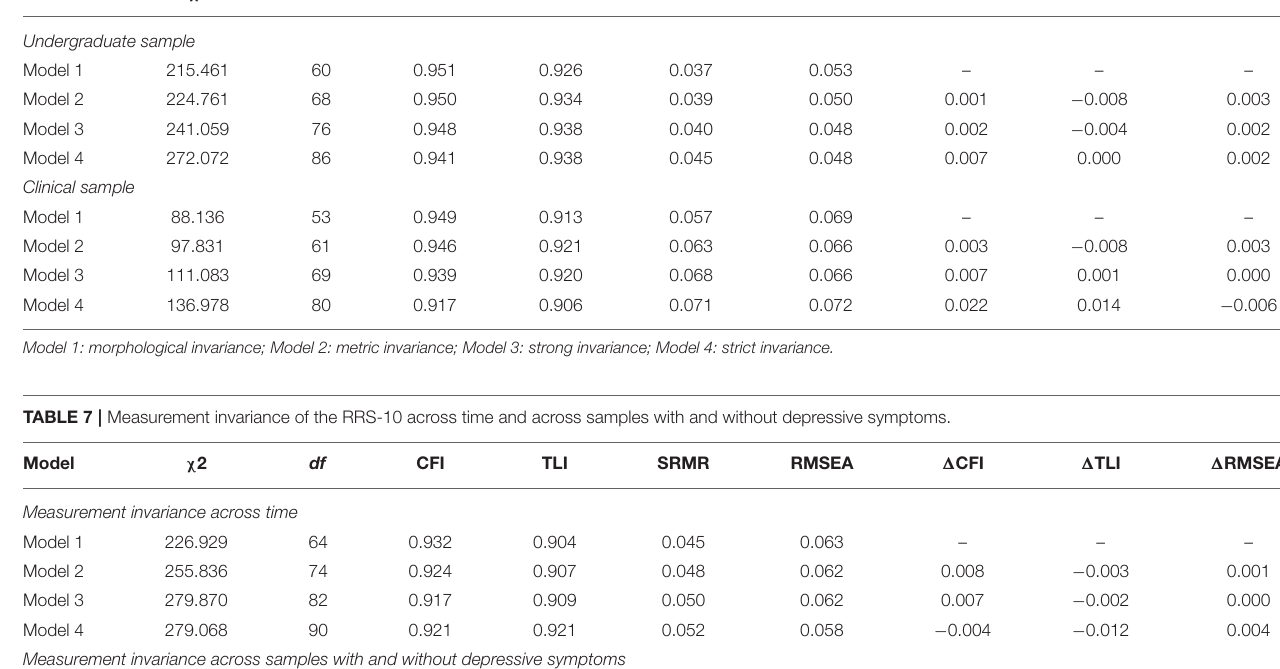
Measurement invariance across samples with and without depressive